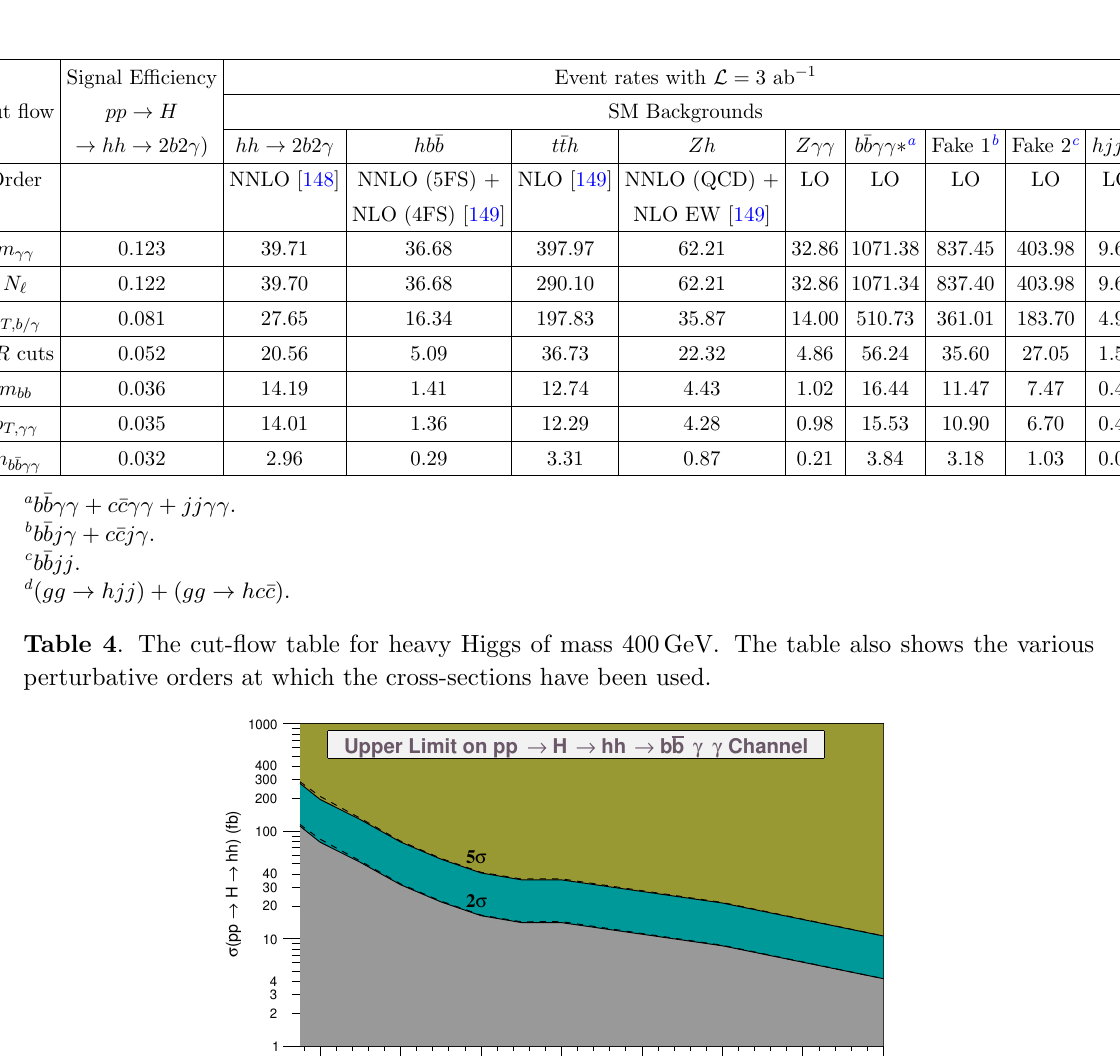
H hh ) (fb) as a function of m H (GeV) for the b (cid:22) b(cid:13)(cid:13) channel ! !